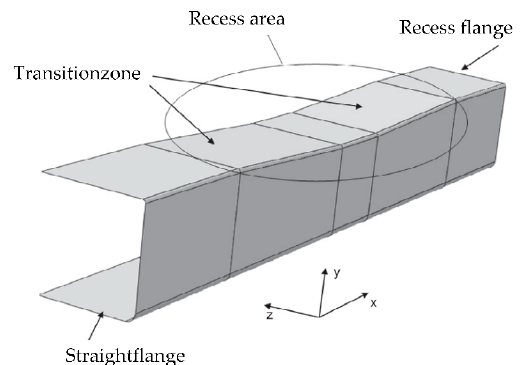
Figure 7. Spar geometry with a flange recess area [28]. Reprinted from Composites: Part A, Vol. 50,